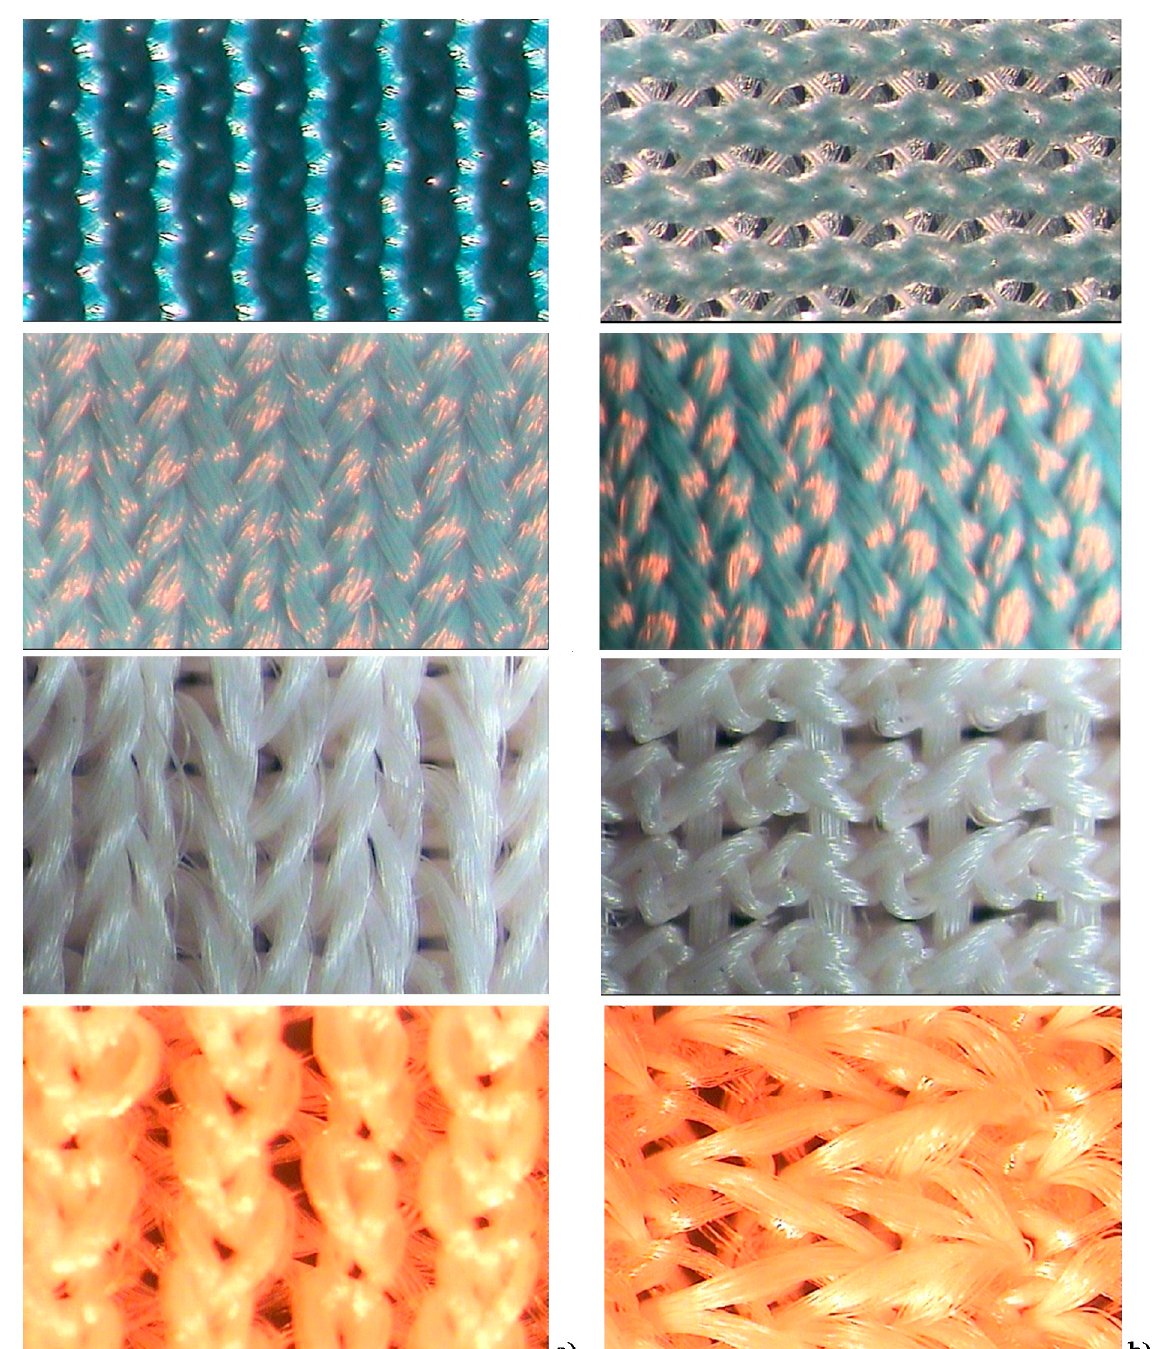
Figure 1. Structure of sample compression fabrics (LB, DB, TL and SW): technical face ( a ) and back face ( b ).